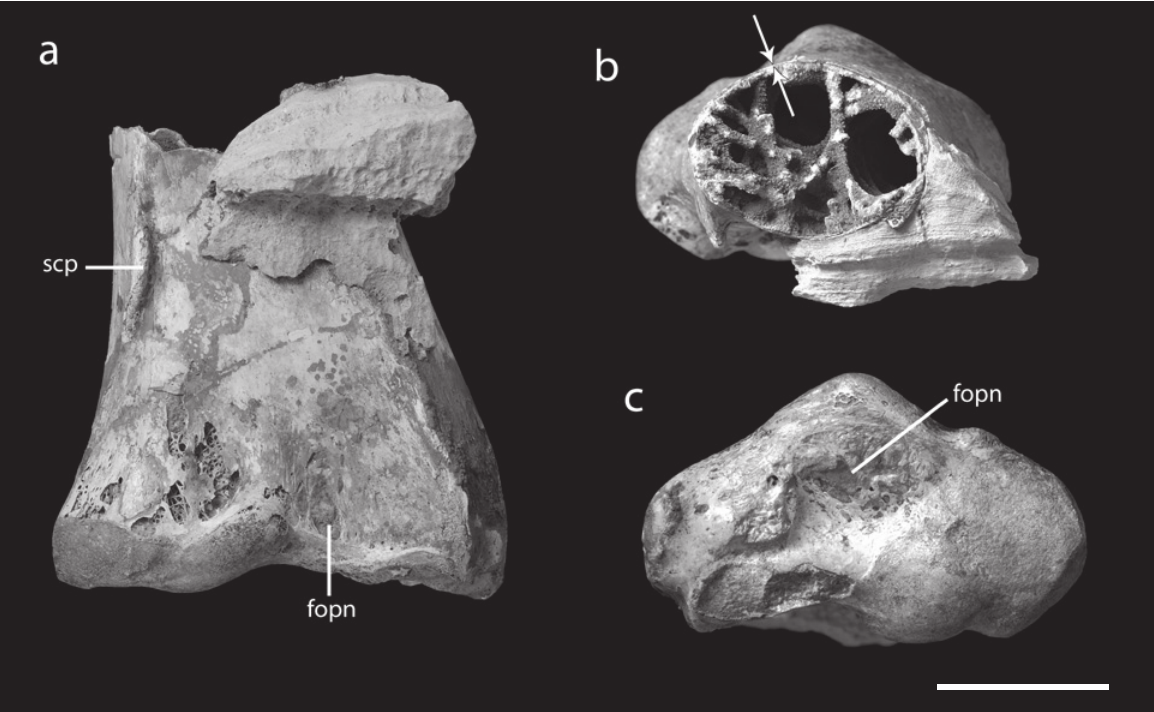
Fig. 9 - MCT 1838-R right humerus. (a) Ventral view. (b) Transverse section, showing the bony trabeculae covered mainly by calcite. (c) Distal view. Arrows indicate the cortical bone. See text for abbreviations. Scale bar 50